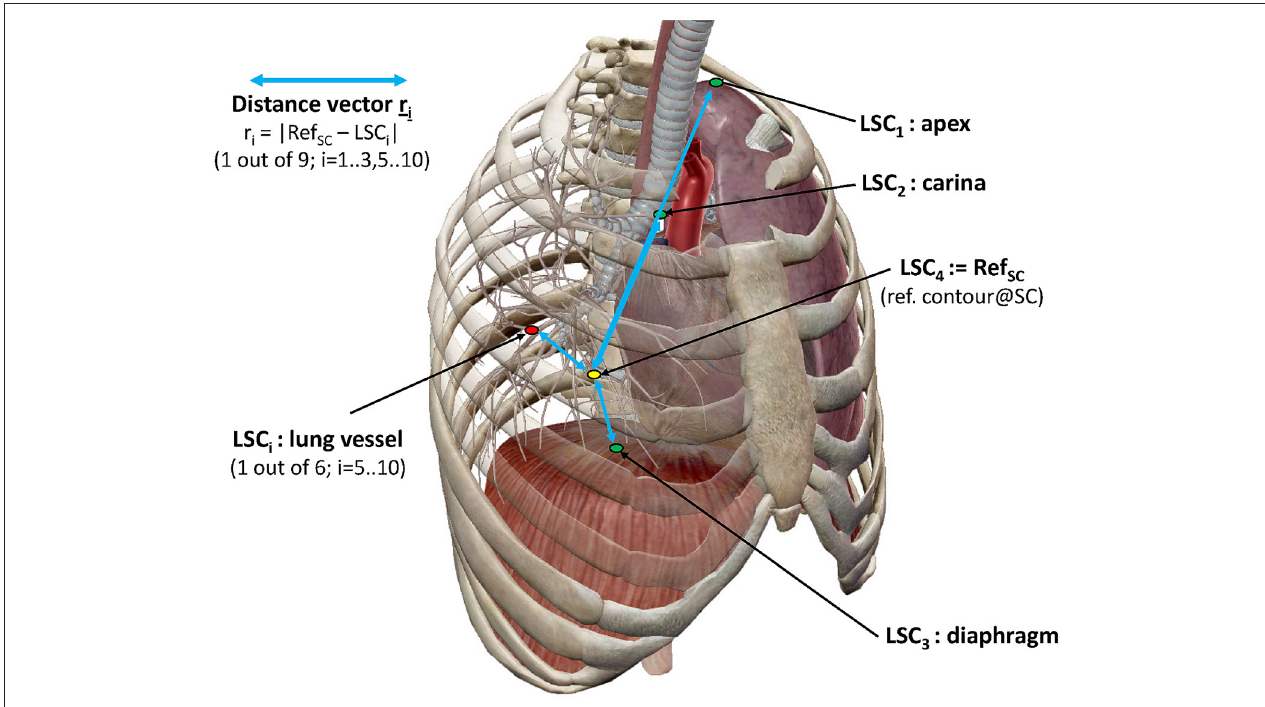
FIGURE 2 | Representation of lung structure metric with selected LSCs. LSC distribution as described in the text (image courtesy of Visible Body ®